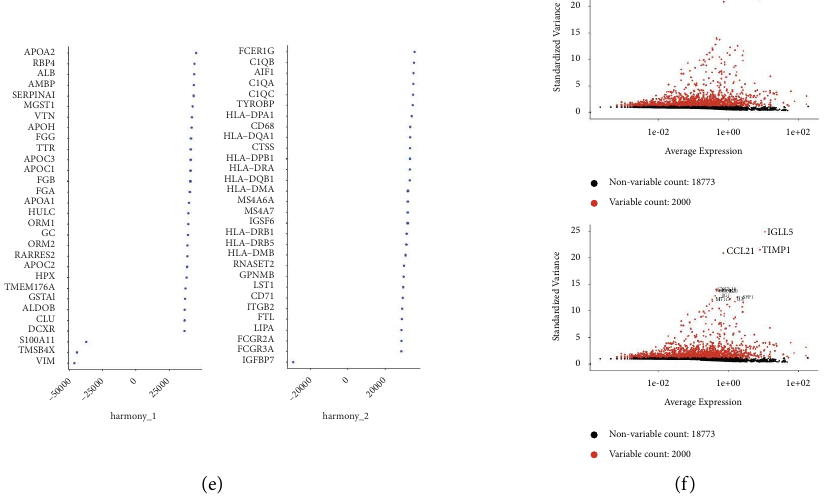
Figure 7: (a) Te amount of mitochondrial genome detected in each cell, the number of molecules detected in the cell, and the number of genes detected in each cell. (b) Comparison of underlying data before fltering. (c) Te correlation between fltered data and the underlying data. (d) Using PCA analysis, multiple PC populations with signifcant diferences can be used as anchor points, showing two parts of PC1 and PC2. (e)-(f) Each point represents a gene, and red represents the top 10 hypervariable genes after batch